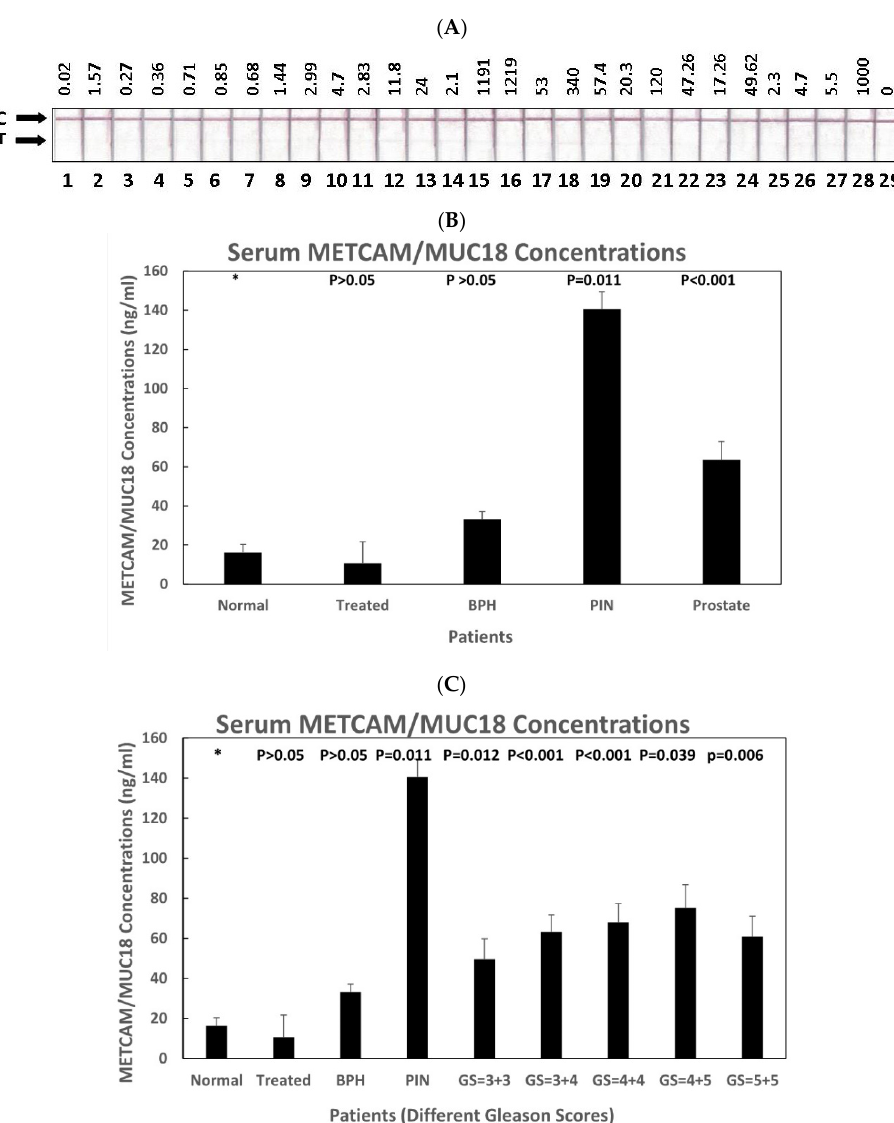
Figure 3. ( A ) Serum image for Combo1, ( B ) METCAM in patients Combo1, ( C ) METCAM in patients with Gleason score combo1. HuMETCAM/MUC18 concentrations in various human serum samples were determined by a modified LFIA method using the combination of biotinylated rabbit antibody (EPP11278) and nanogold-conjugated chicken antibody and its relation to the status of patients. ( A ) shows the intensities of various human serum samples on the test lines (T). The top numbers show the prostate-specific antigen (PSA) score for each patient. ( B ) shows the average METCAM/MUC18 concentrations with standard deviations in the serum samples from the treated prostate cancer patients, prostate cancer patients, patients with prostate premalignant prostatic intraepithelial neoplasia (PIN), or benign prostatic hyperplasia (BPH), were compared to those from normal individuals. The number on top of each bar was the p value when the data were compared to the normal after statistical analysis, as described in “Materials and Methods.” ( C ) shows the average METCAM/MUC18 concentrations with standard deviations in the serum samples from the treated prostate cancer patients, prostate cancer patients with different Gleason score, and patients with prostate premalignant PIN, or BPH, compared to those from normal individuals. The number on top of each bar was the p value when the data were compared to the normal after statistical analysis, as described in “Materials and Methods.”